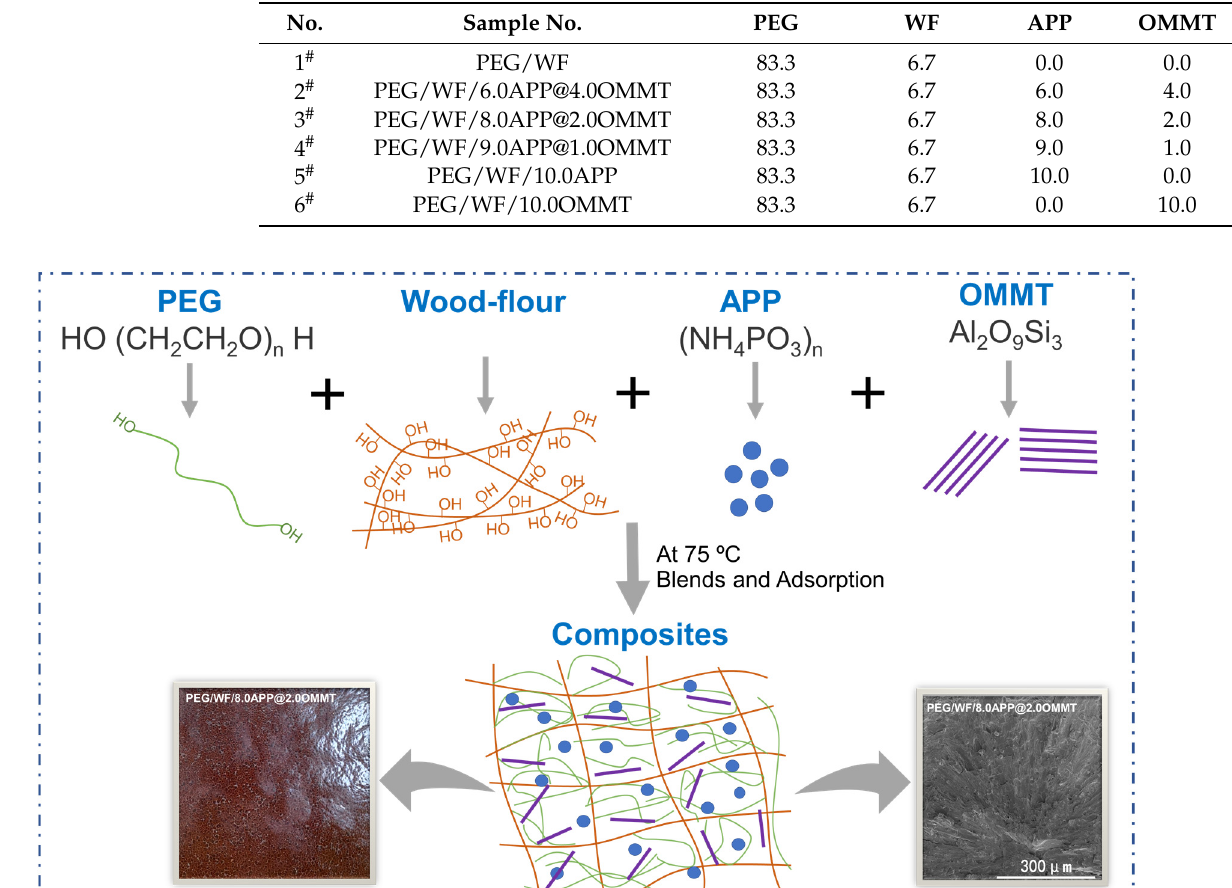
Table 6. Specific formulation of PEG/WF hybrid phase change composites (wt.%).